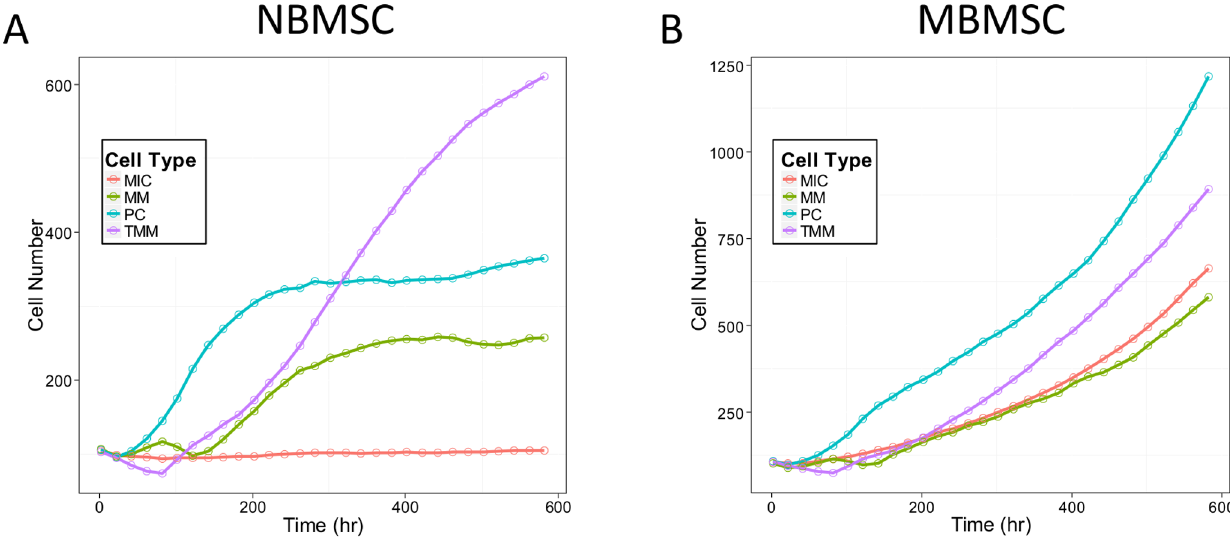
Figure 4. Profiles of simulation results. The growing trends of each tumor cell type under (A) NBMSC or (B) MBMSC environments were visualized.